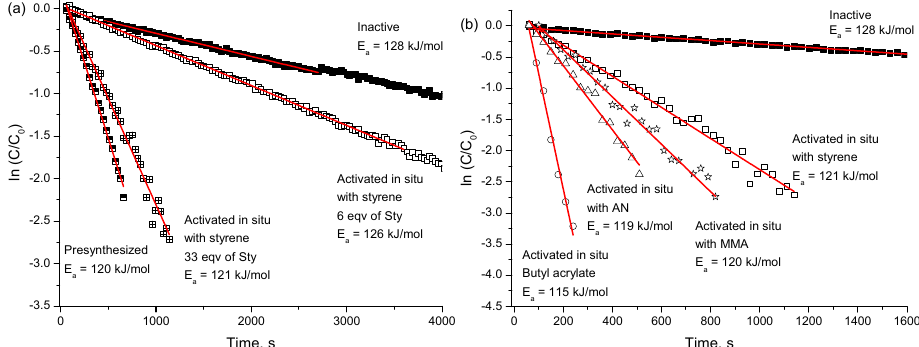
Figure 15. Kinetics of inactive alkoxyamine decomposition under various conditions. ( a ) Black squares: pure inactive alkoxyamine 29, white squares: 6 eq. of styrene, crossed squares: 33 eq. of styrene, half-colored squares: presynthesized with styrene alkoxyamine. ( b ) Black squares: pure inactive alkoxyamine, white squares: 33 eq. of styrene, white stars: 30 eq. of MMA, white triangles: 30 eq. of acrylonitrile, white circles: 35 eq. of butyl acrylate. Red lines: a linear fit of experimental data points. The temperature in all experiments is 373 K. The solvent is C 6 D 4 Cl 2 . Adapted from Ref. [52] with permission from The Royal Society of Chemistry.